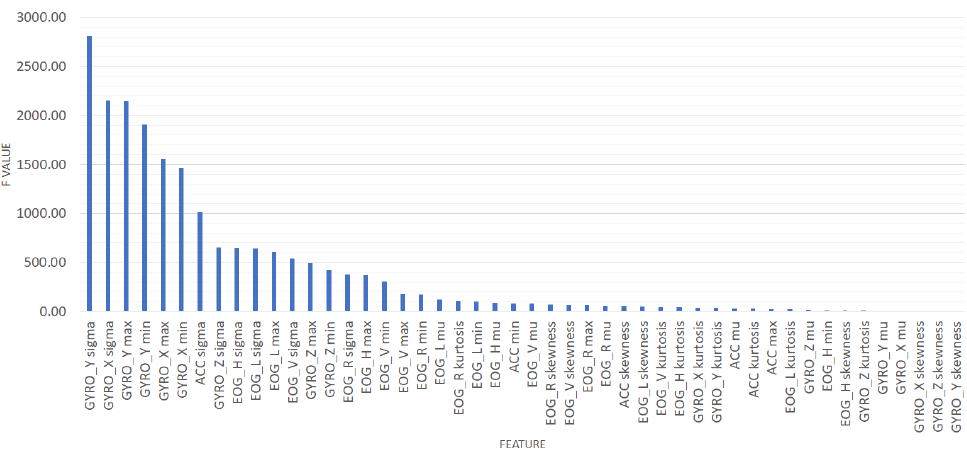
Figure 2. All features ranked by decreasing ANOVA F